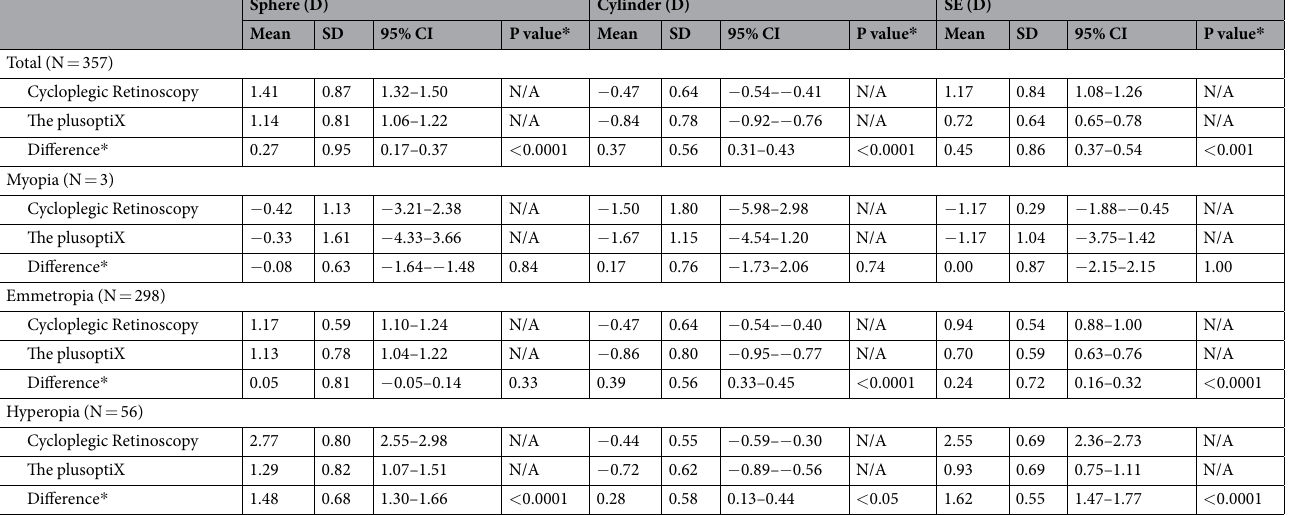
Table 2. Comparison between the plusoptiX and Cycloplegic Retinoscopy. SE, spherical equivalent; * Comparison between the Plusoptix A12C and cycloplegic retinoscopy; N/A, not